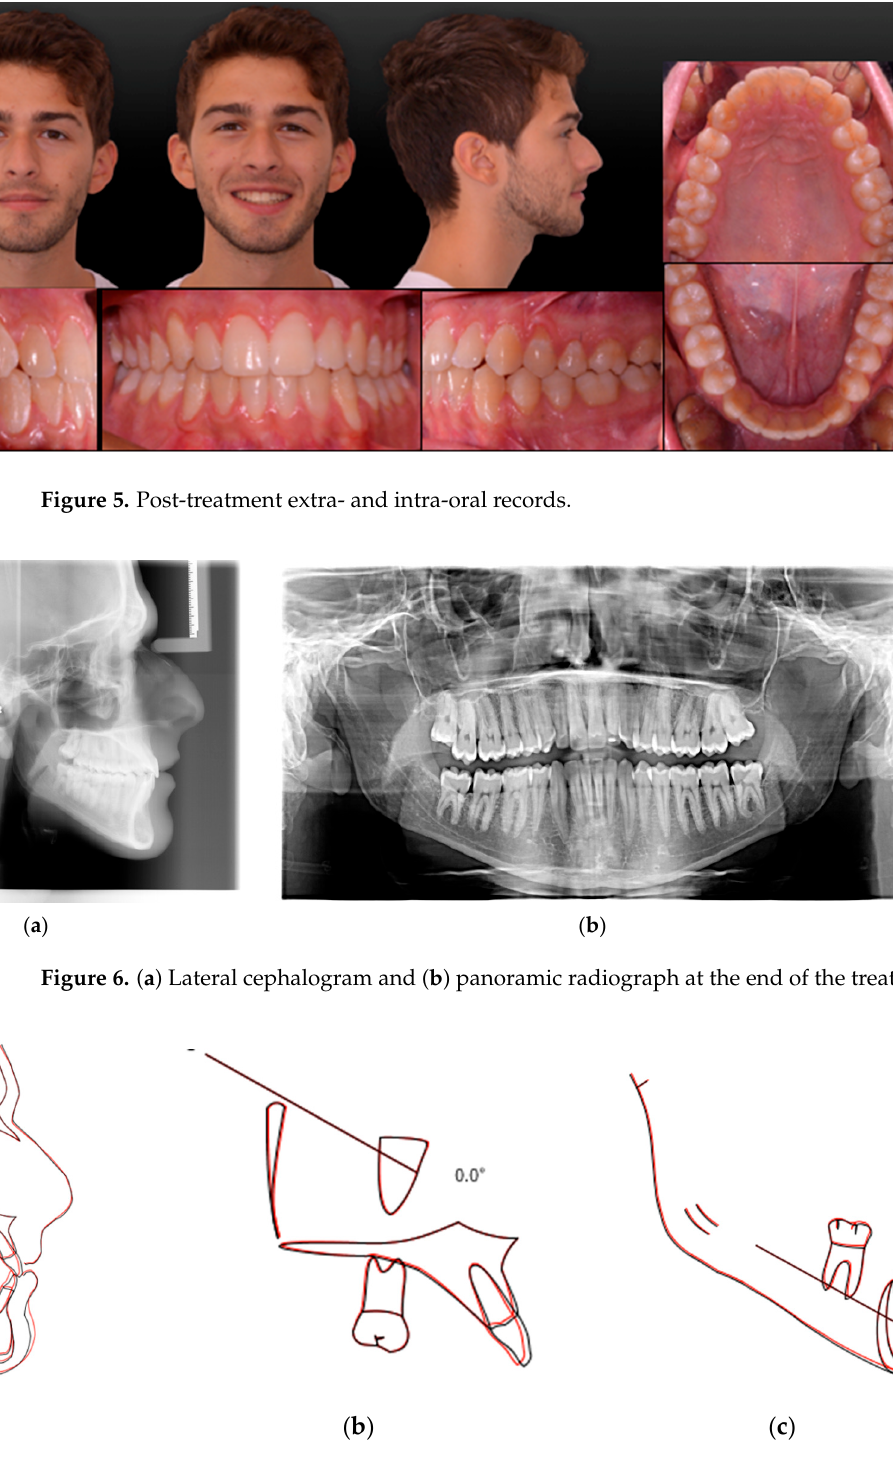
Figure 7. Total ( a ), maxillary ( b ), and mandible ( c ) cephalometric tracing superimposition before (black) and after (red) treatment.